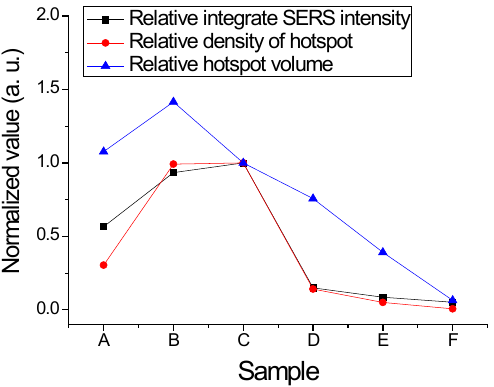
Figure 14. The relative densities of hotspots in the AgNP samples.